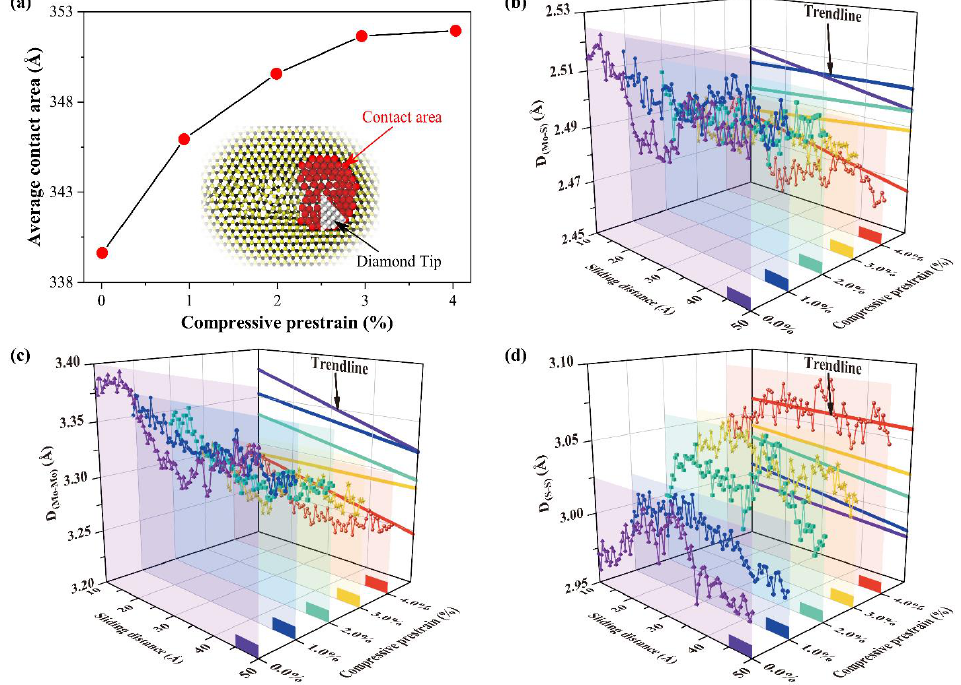
Figure 8. ( a ) The average contact area between the diamond tip and MoS 2 with different in-plane compressive prestrain, obtained by averaging the contact area during the sliding process; Evolution of D (Mo–S) ( b ), D (Mo–Mo) ( c ), and D (S–S) ( d ) for atoms in the contact area between the diamond tip and MoS 2 , when the friction is stable.